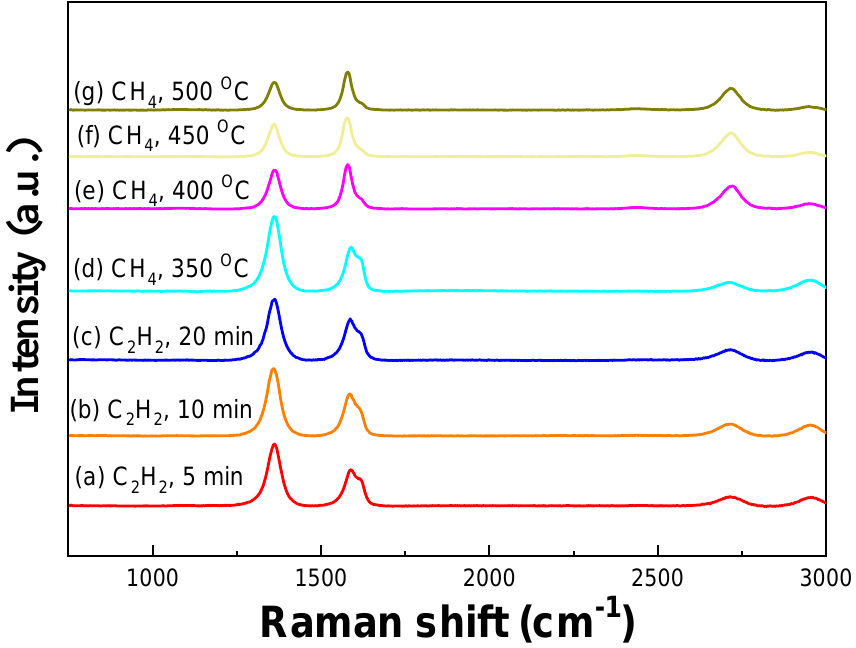
Figure 2. Raman spectra of chemical vapor deposition (CVD) graphene using C 2 H 2 as carbon source at 600 °C for ( a ) 5 min, ( b ) 10 min, and ( c ) 20 min on Cu; Raman spectra of CVD graphene using CH 4 as carbon source at ( d ) 350 °C, ( e ) 400 °C, ( f ) 450 °C, and ( g ) 500 °C for 5 min on Cu. Table 1. Characteristics of Raman spectra for low-temperature chemical vapor deposition (LTCVD) graphene films using different conditions.